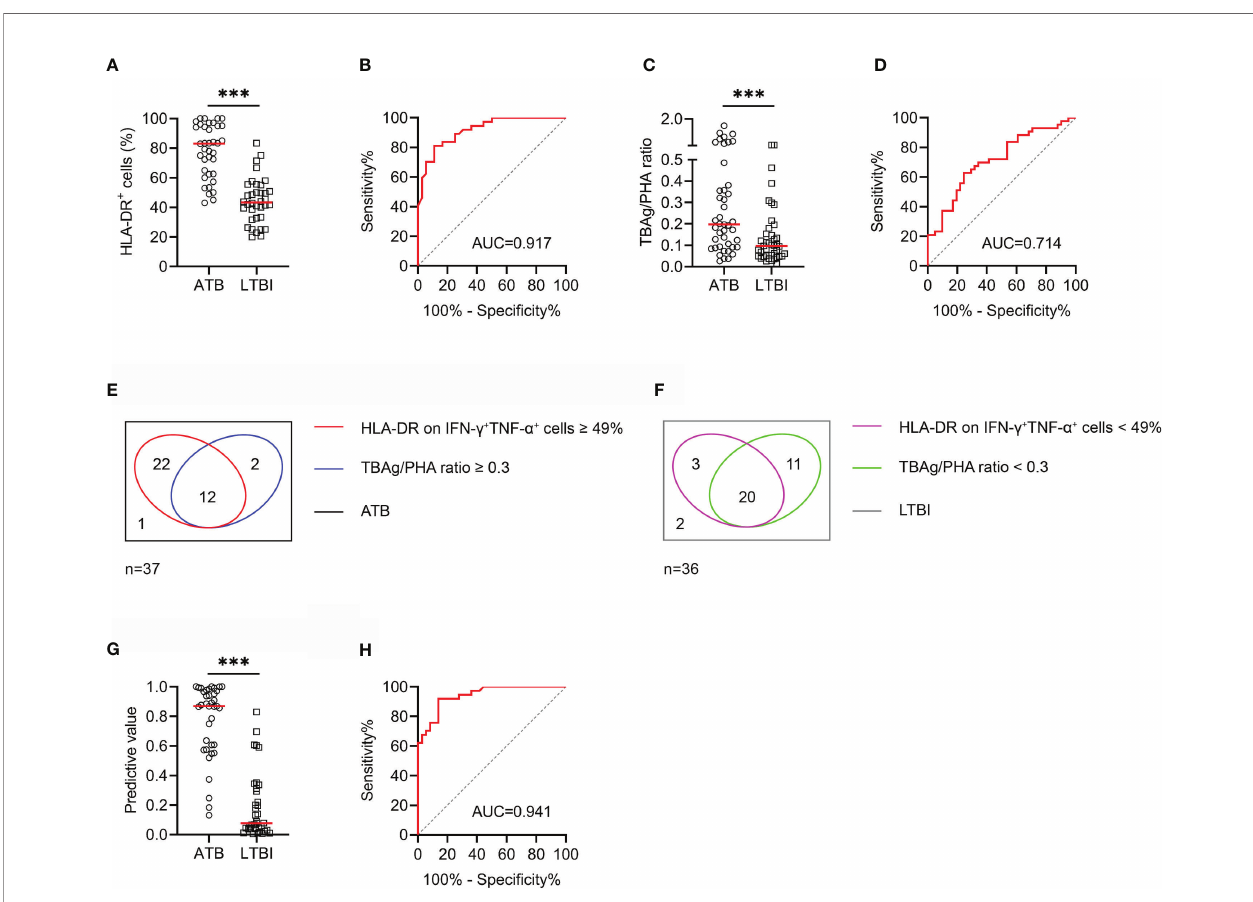
FIGURE 4 | The performance of various indicators in distinguishing ATB patients from LTBI individuals in Caidian cohort. (A) Scatter dot plots showing the results of the expression of HLA-DR on IFN- g + TNF- a + cells in ATB patients and LTBI individuals. Horizontal lines indicate the medians. *** P < 0.001 (Mann-Whitney U test). (B) ROC curve analysis showing the performance of HLA-DR on IFN- g + TNF- a + cells in discriminating ATB patients from LTBI individuals. (C) Scatter dot plots showing the results of TBAg/PHA ratio in ATB patients and LTBI individuals. Horizontal lines indicate the medians. *** P < 0.001 (Mann-Whitney U test). (D) ROC curve analysis showing the performance of TBAg/PHA ratio in discriminating ATB patients from LTBI individuals. (E) Venn diagrams showing the overlap of HLA-DR on IFN- g + TNF- a + cells and TBAg/PHA ratio in ATB patients. (F) Venn diagrams showing the overlap of HLA-DR on IFN- g + TNF- a + cells and TBAg/PHA ratio in LTBI individuals. (G) Scatter plots showing the predictive value of diagnostic model in ATB patients and LTBI individuals. Horizontal lines indicate the medians. *** P < 0.001 (Mann-Whitney U test). (H) ROC curve analysis showing the performance of diagnostic model based on the combination of HLA-DR on MTB-speci fi c cells and TBAg/PHA ratio in discriminating ATB patients from LTBI individuals. MTB, Mycobacterium tuberculosis ; ATB, active tuberculosis; LTBI, latent tuberculosis infection; TBAg, tuberculosis antigens; PHA, phytohemagglutinin; AUC, area under the